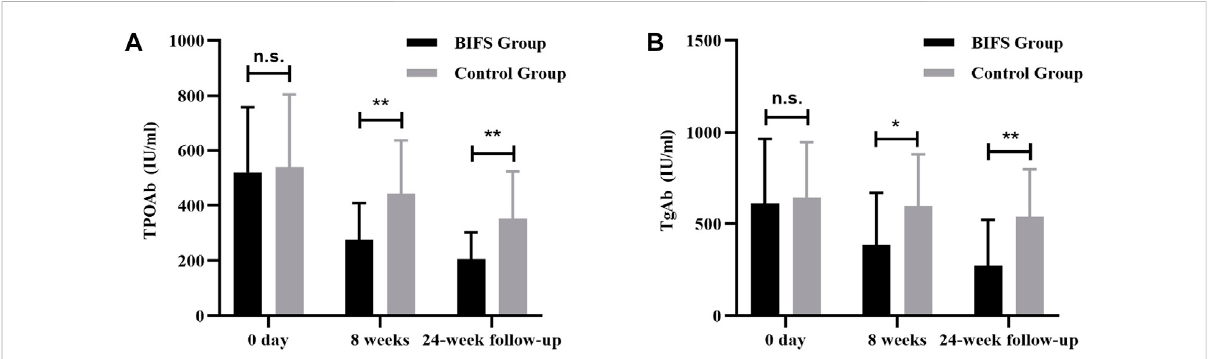
FIGURE 4 TPOAb and TGAb titers at baseline, after eight treatment weeks, and at 24-week follow-up. (A) TPOAb titer; (B) TGAb titer; n.s., no statistically signi fi cant difference; * p < 0.05; ** p <